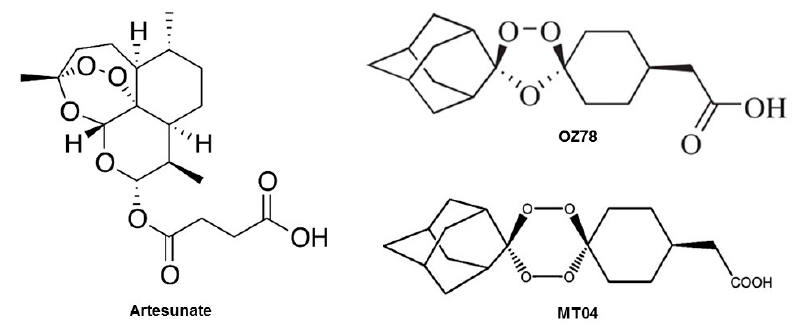
Figure 1. Molecular structure of artesunate, OZ78, and MT04.